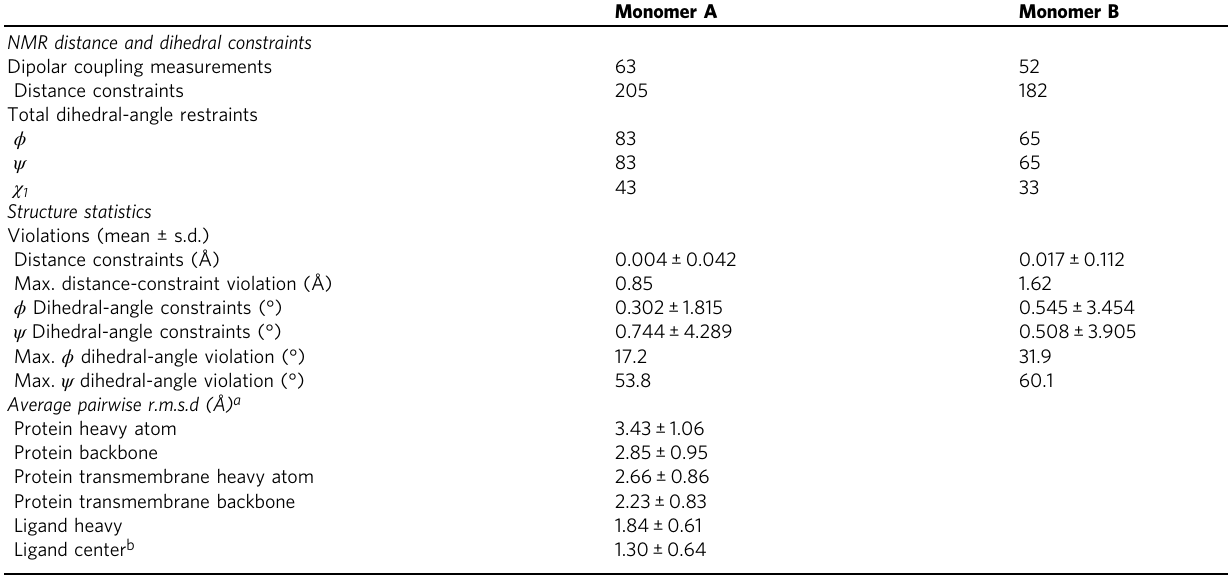
a Pairwise RMSD was calculated among 10 lowest-violation structures between the two independent MD runs after the re fi nement had equilibrated. b Ligand center is operationally de fi ned as phosphorus and the four directly bonded carbon atoms of F 4 -TPP + .